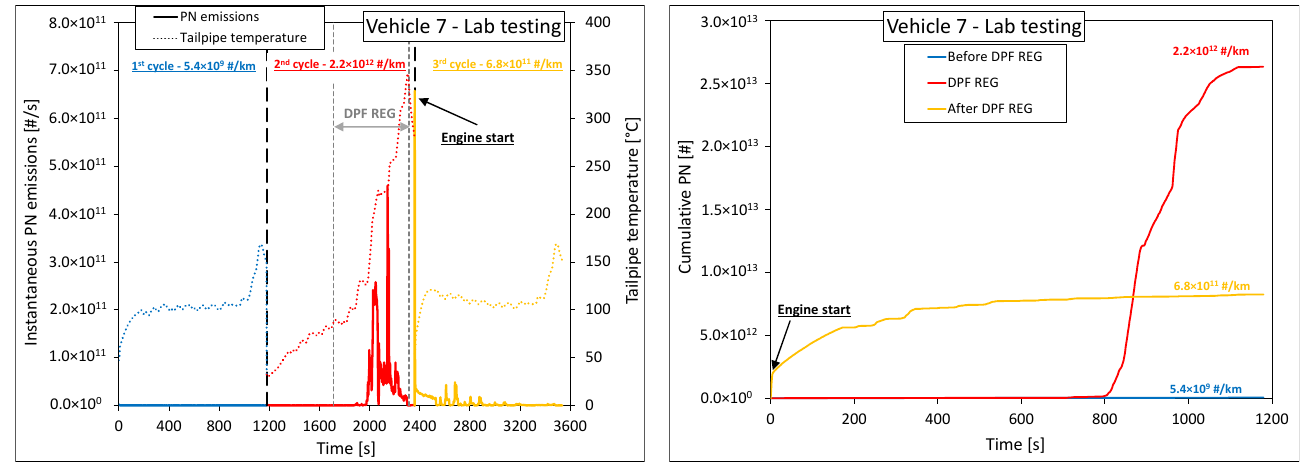
Figure 6. Tailpipe and lambda profiles during the motorway route with DPF regeneration.